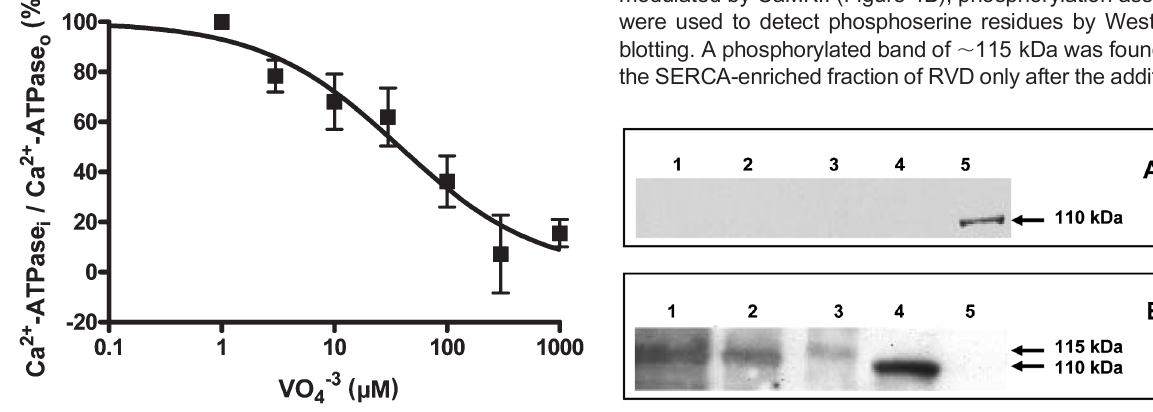
Figure 3. Expression of sarco(endo)plasmic reticulum Ca 2 + - ATPase (SERCA) isoforms. A , Immunoblotting with anti-SERCA1 antibody and B , immunoblotting with anti-SERCA2 antibody. Lane 1 = 24 m g SERCA-enriched fraction; lane 2 = 32 m g of crude homogenate; lane 3 = 4 m g of chicken cerebellum microsomes (positive control for SERCA2b); lane 4 = 10 m g of rat heart microsomes (positive control for SERCA2a); lane 5 = 0.4 m g (in A ) or 10 m g (in B ) of heavy microsomes of rat fast skeletal muscle (positive control for